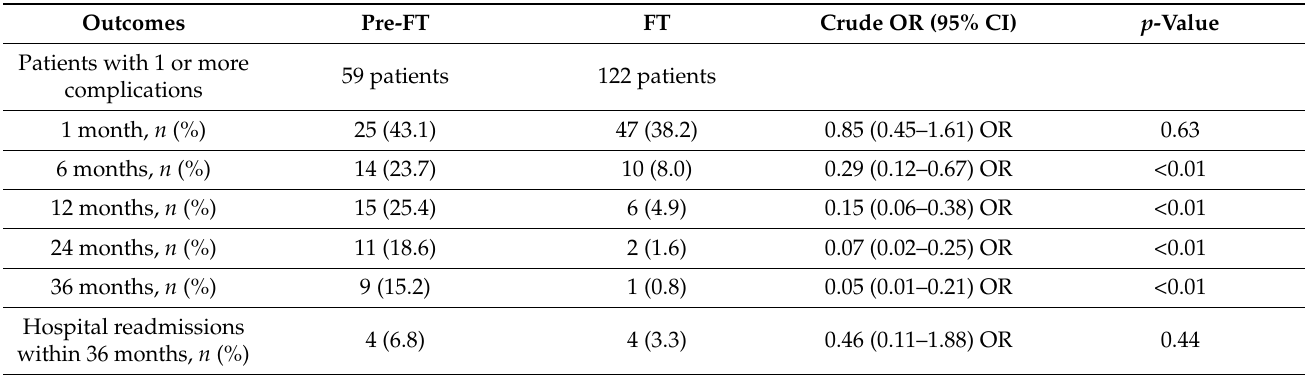
Table 5. Impact of the FT protocol on long-term complications and readmissions of the two patient groups.